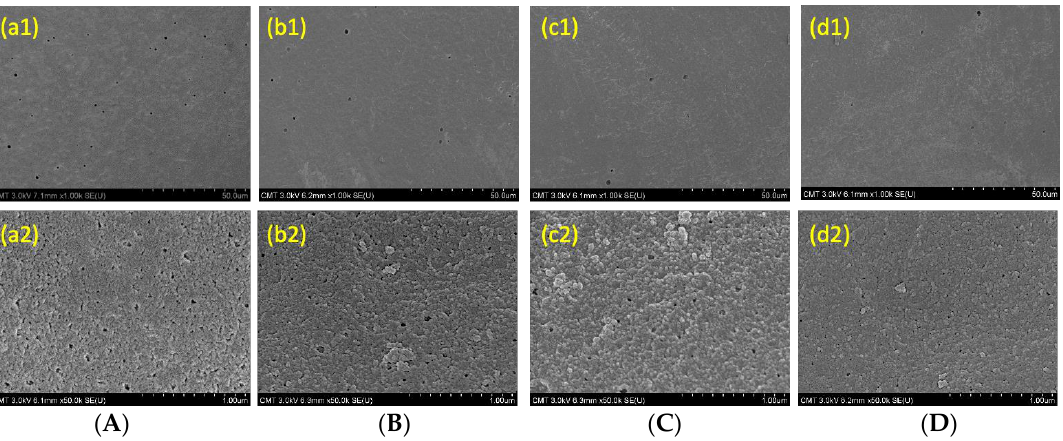
Figure 1. The outer surface SEM images of TA-FeIII/PAN membranes with different treatment